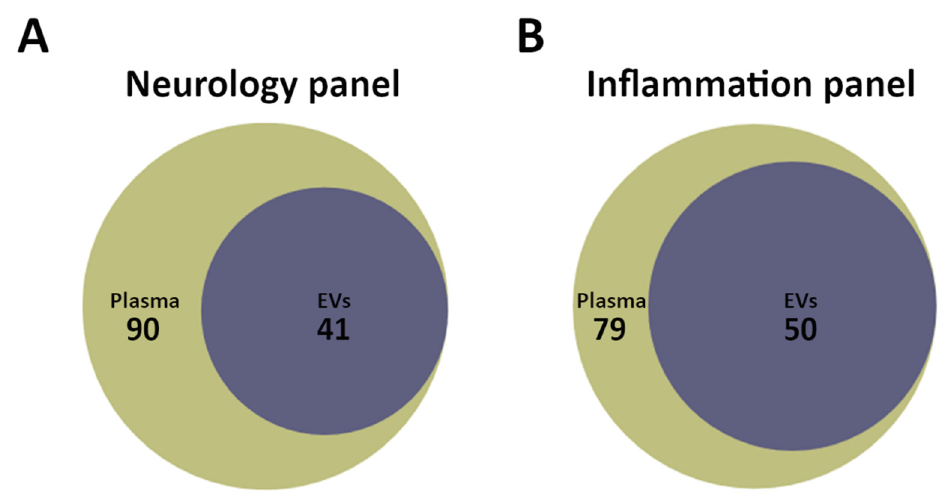
Figure 2. Area proportional Venn diagrams were created for visual representation of number of proteins in plasma and EV samples measured by proximity extension assay (PEA) using the Neurology and Inflammation panels. ( A ) For the Neurology panel, 90 proteins were detected in plasma with 41 proteins expressed in EV samples and 49 proteins only in plasma. ( B ) For the Inflammation panel, 79 proteins were detected in plasma with 50 proteins expressed in the EV samples and 29 proteins only in plasma.